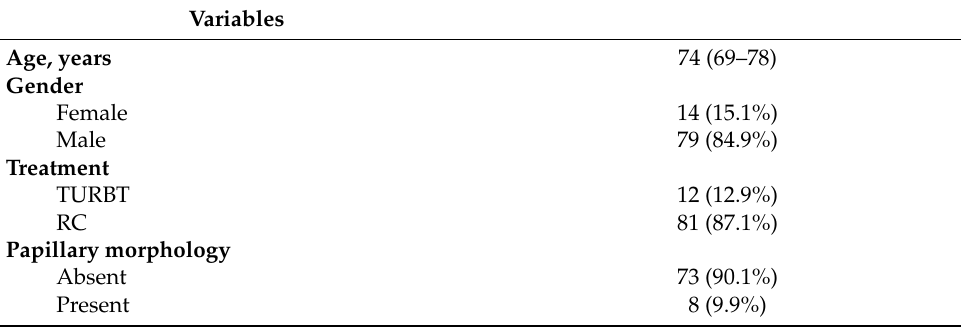
Table 1. Clinicopathological characteristics of our